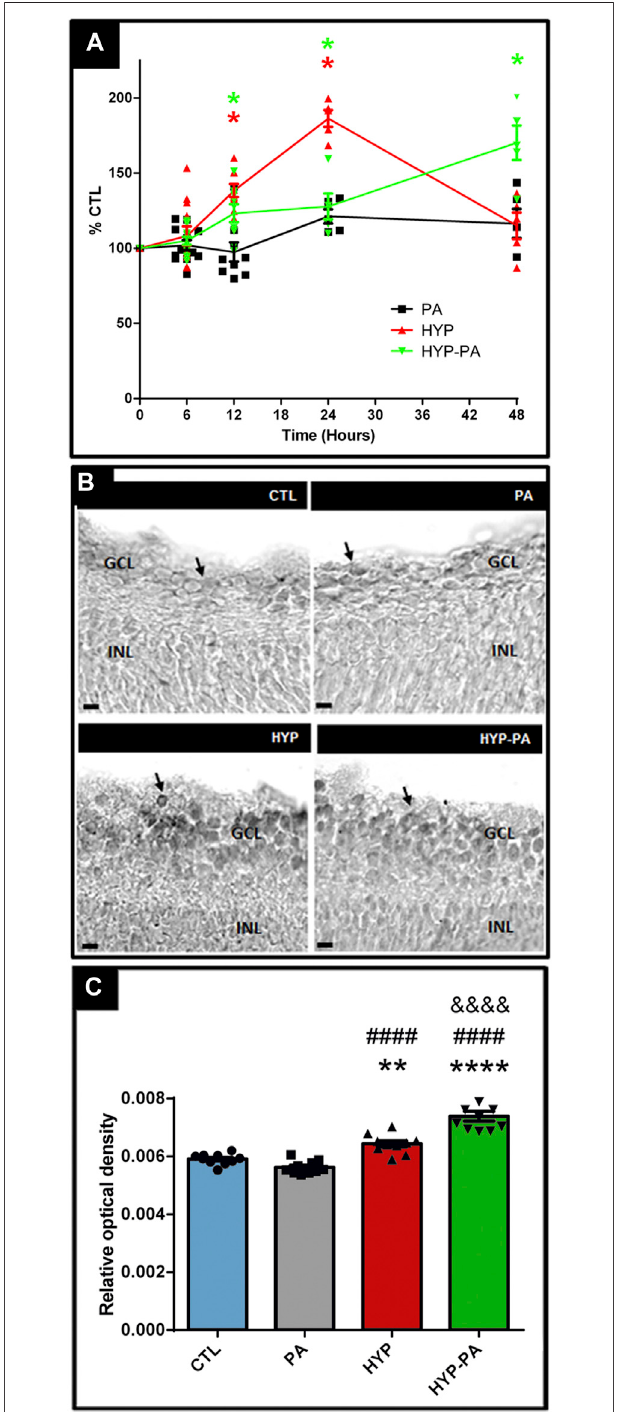
FIGURE 6 | CIRPexpressionisinducedbyhypothermia. (A) :RelativeCIRP mRNA expression through time as measured by qRT-PCR. The time-course expression of CIRP showed signi fi cant changes among treatments from 12 to 48 h after asphyxia. Signi fi cant induction of CIRP mRNA expression was determinedinallgroupscompared toCTL,however 48 hafterperinatalasphyxia, CIRP expression remained signi fi cantly increased only in the HYP-PA animals. All